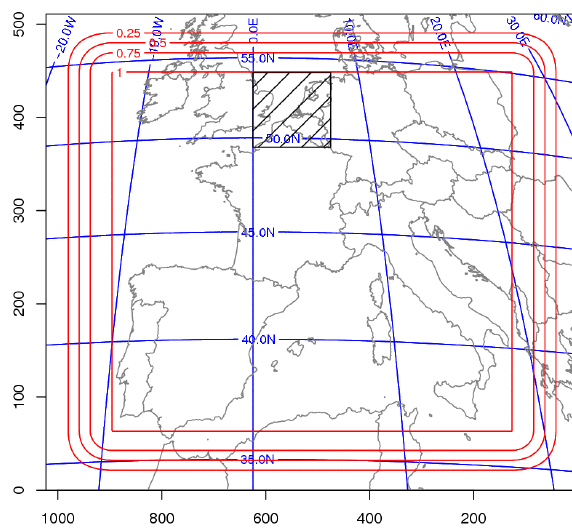
Fig. 3. Region of the SEVIRI field of view used for this paper, consisting of 1024 × 512 pixels. Also shown are contours of latitude and longitude in blue, and of the amplitude of the window function used for Fourier analysis in red. The subregion shown in Fig. 4 is marked by a black shaded